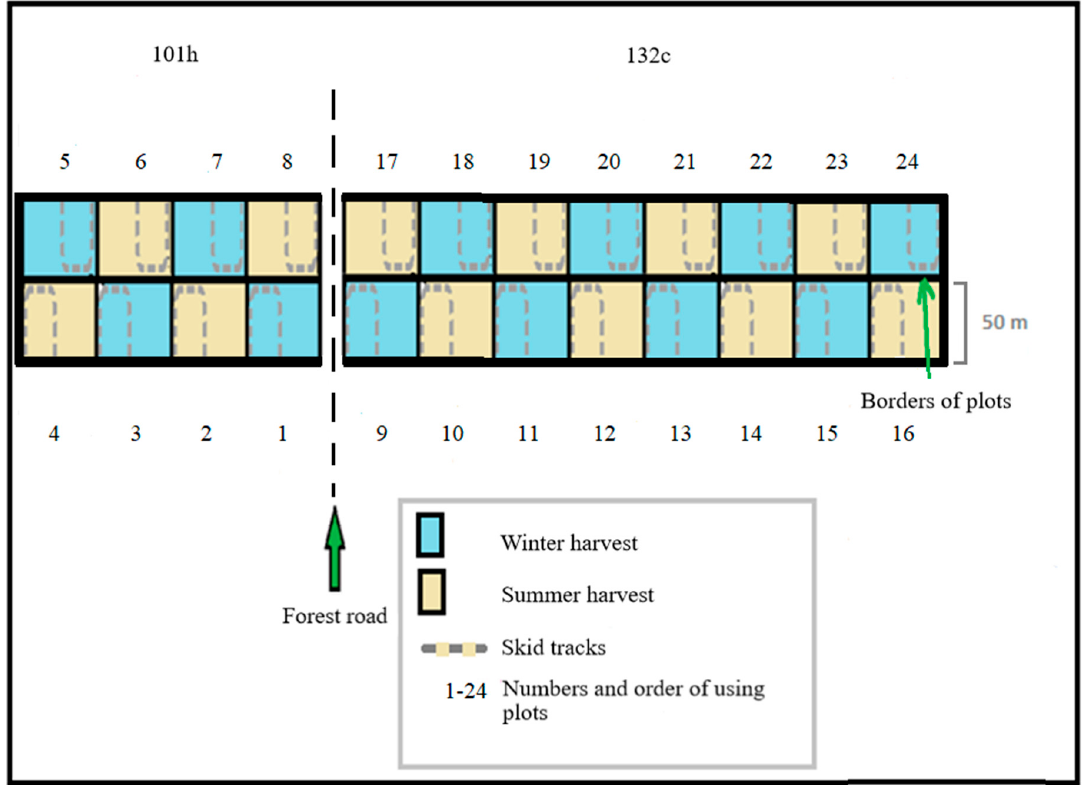
Figure 2. Scheme of research plots set-up.